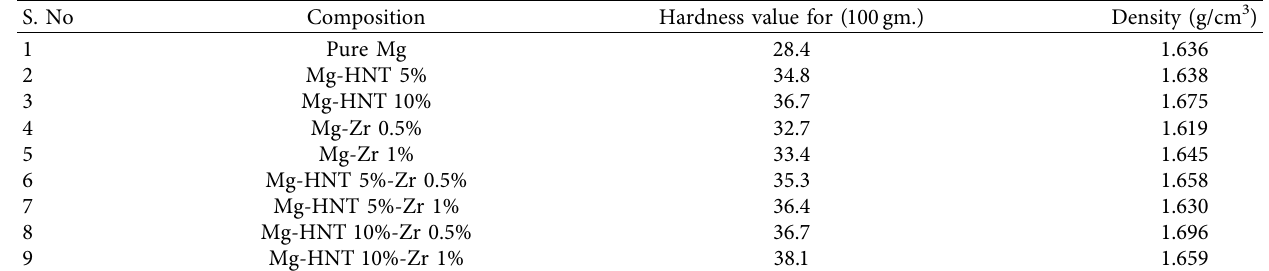
Table 1: Results of hardness and density tests.